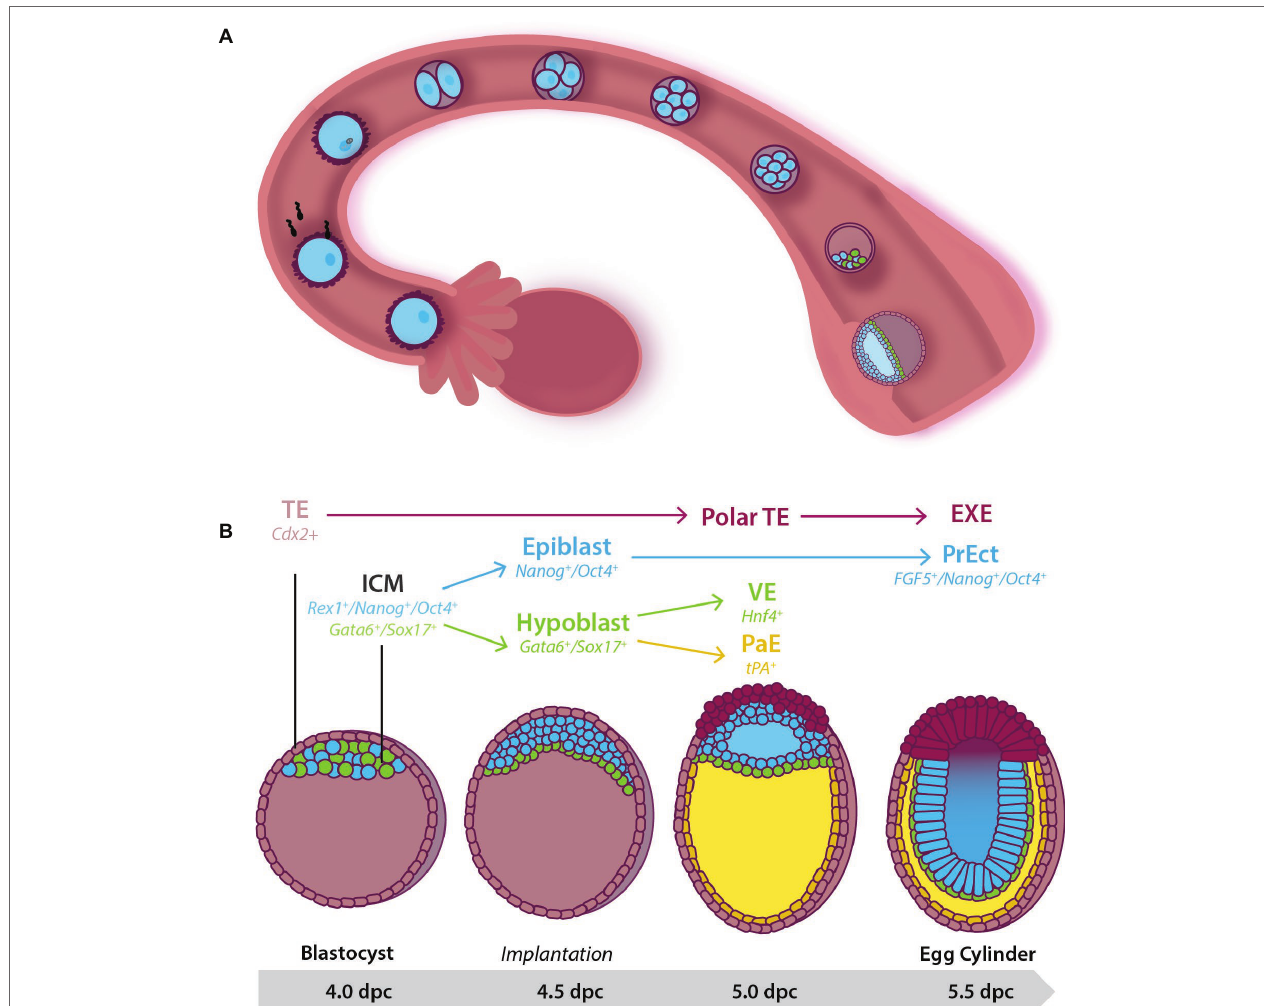
FIGURE 1 | Early pre- and post-implantation mouse embryonic development until the egg cylinder stage. (A) Following fertilization, the embryo undergoes a series of cleavage divisions as it travels down the fallopian tube. Between 3.5 and 4.5 dpc, the embryo, now known as a blastocyst, consists of two cell populations: An outer multipotent trophectoderm (TE) (expressing Cdx2 ), and a mosaic inner pluripotent inner cell mass (ICM) population. At 4.0 dpc, the blastocyst hatches from the zona pelucida and implants into the uterine wall. (B) Cells of the 4.0 dpc ICM expressing Gata6 and Sox17 move to line the blastocoelic cavity, lose pluripotency, and differentiate into the extraembryonic primitive endoderm (or hypoblast) by 4.5 dpc. Together the remaining cells of the ICM (the epiblast) and the hypoblast form the bilaminar disc by 5.0 dpc. At this stage, cells of the pluripotent epiblast that have not moved to be in contact with the extracellular matrix laid down between the hypoblast undergo apoptosis to help form the proamniotic cavity. Hypoblast cells that remain in close contact with the epiblast differentiate into visceral endoderm (VE) while those that migrate along the basement membrane of the TE form the tPA + parietal endoderm (PaE), resulting in the formation of the yolk sac. At 5.5 dpc the embryo is known as the egg cylinder. The remaining surviving epiblast cells have differentiated into a second pluripotent population of pseudo-stratified cells known as the primitive ectoderm (PrEct). The TE differentiates into cells that constitute the placenta including the extraembryonic endoderm